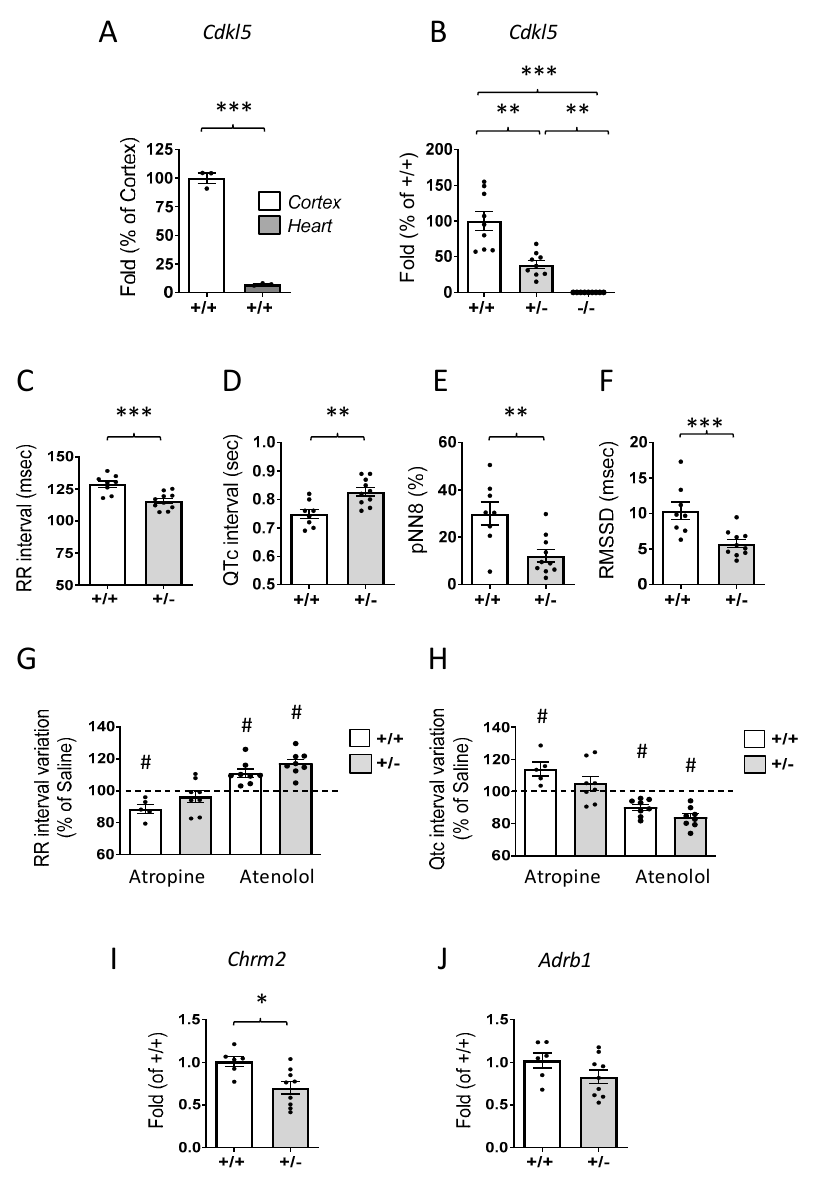
Figure 1. Cdkl5 expression in the heart of Cdkl5 +/ − mice and ECG analysis. ( A ) Real-time qPCR analysis of Cdkl5 mRNA expression in the cortex (n = 3) and heart (n = 3) of 3-month-old wild-type Cdkl5 +/+ mice. Data are presented as a percentage of Cdkl5 cortical expression. *** p < 0.001 (two- tailed Student’s t -test). ( B ) Relative Cdkl5 mRNA expression in the heart of 3-month-old Cdkl5 +/+ (n = 6) heterozygous Cdkl 5 +/ − (n = 9) and homozygous Cdkl5 − / − (n = 9) female mice. The results are expressed as percentages of Cdkl5 cardiac expression in Cdkl5 +/+ mice. ** p < 0.01; *** p < 0.001 (Fisher’s LSD test after one-way ANOVA). ( C ) Mean heart period duration (expressed as intervals between two consecutive R waves) during non-rapid-eye-movement sleep (NREMS) in Cdkl5 +/+ (n = 8) and Cdkl5 +/ − (n = 10) female mice. ( D ) Mean duration of ventricular depolarization and repolarization (interval between Q and T waves) during NREMS. These values are reported as corrected QT intervals (QTc) after applying Hodge’s formula to consider potential differences in RR values between groups ( Cdkl5 +/+ (n = 8) and Cdkl5 +/ − (n = 10) female mice). ( E ) Percentage of RR values that differ from the following values by more than 8 ms (pNN8) during NREMS in Cdkl5 +/+ (n = 8) and Cdkl5 +/ − (n = 10) female mice. ( F ) Root mean square of the successive RR differences (RMSSD) during NREMS in Cdkl5 +/+ (n = 8) and Cdkl5 +/ − (n = 10) female mice. The results in ( C – F ) are presented as means ± SEM. ** p < 0.01, *** p < 0.001 (two-tailed Student’s